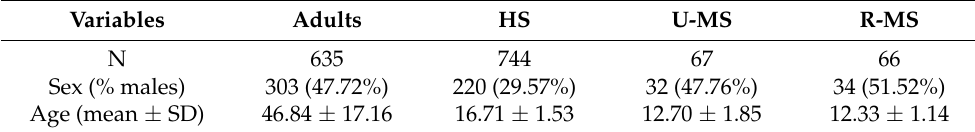
Table 1. Baseline characteristics of the whole sample by subgroups.